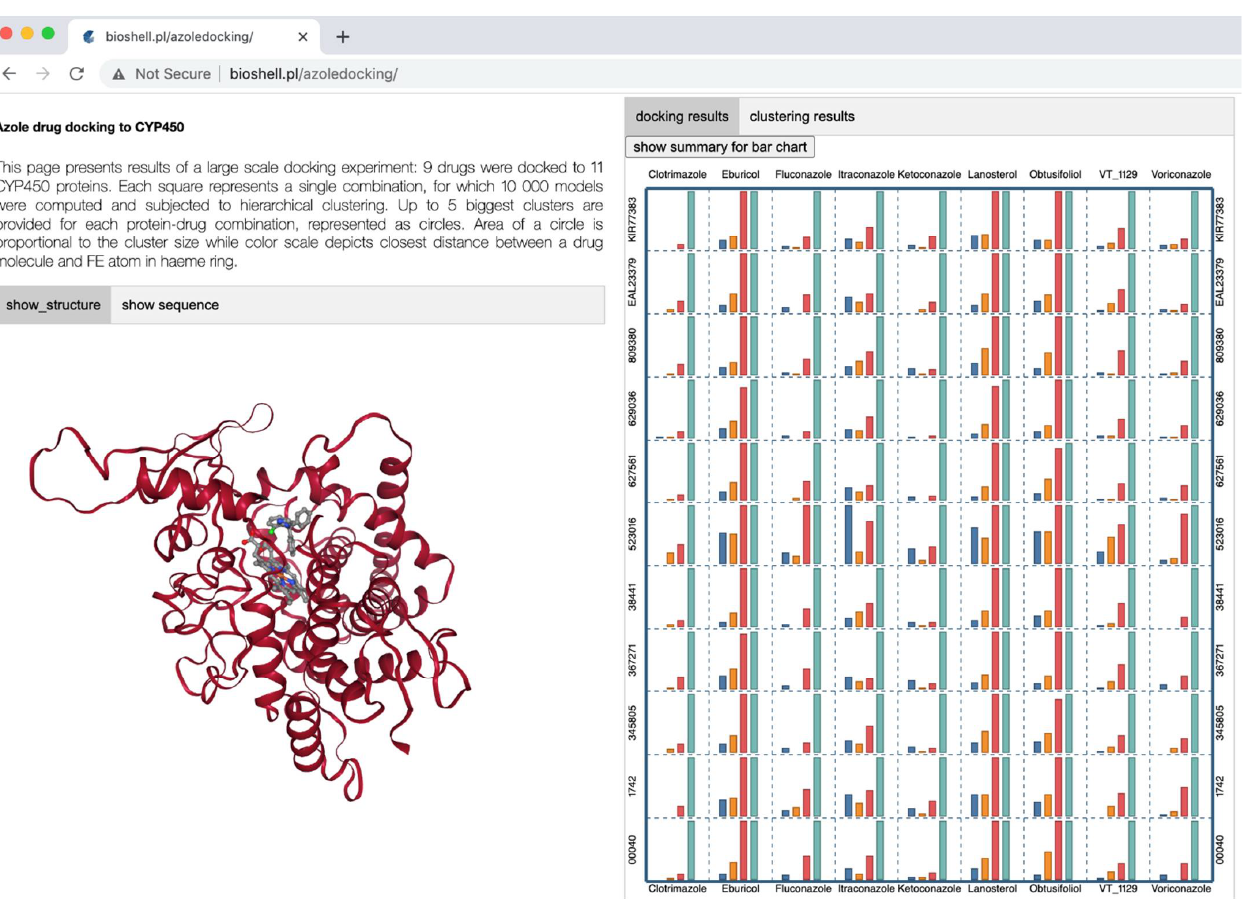
Figure 4. This graphical overview of docking results at online web application. There are 99 squares representing the 11 x 9 = 99 CYP51-ligand combinations considered in this work. CYP51s were indicated with their protein IDs. Each square displays up to four bars, corresponding to models classified as ‘clashes’, ‘correct’, ‘near’, and ‘pocket’ (blue, orange, red, and cyan, respectively). Bars taller than 60 observations were reduced to 60 to fit into a plotting area; actual values are provided in Table 1. Docking results and corresponding information can be accessed at our online web application (Http://Bioshell.Pl/Azoledocking/).